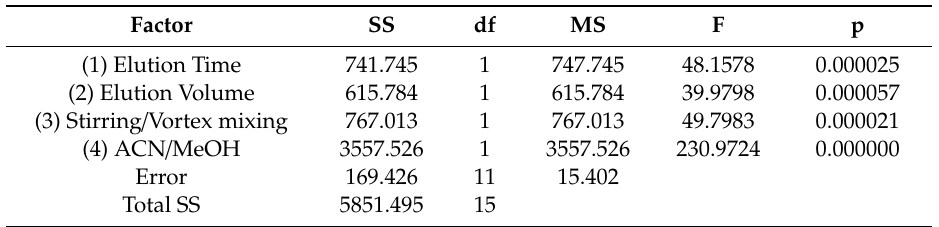
Table 2. ANOVA results obtained by 3 2